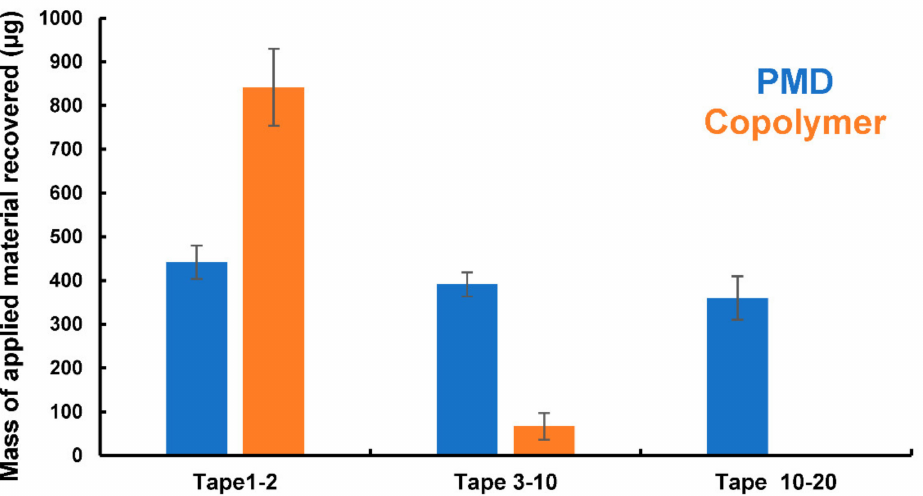
Figure 6. Skin uptake of PMD (control) and AA/APMD (30:70) copolymer in full-thickness porcine skin. Data presented as mean ± SD ( n =